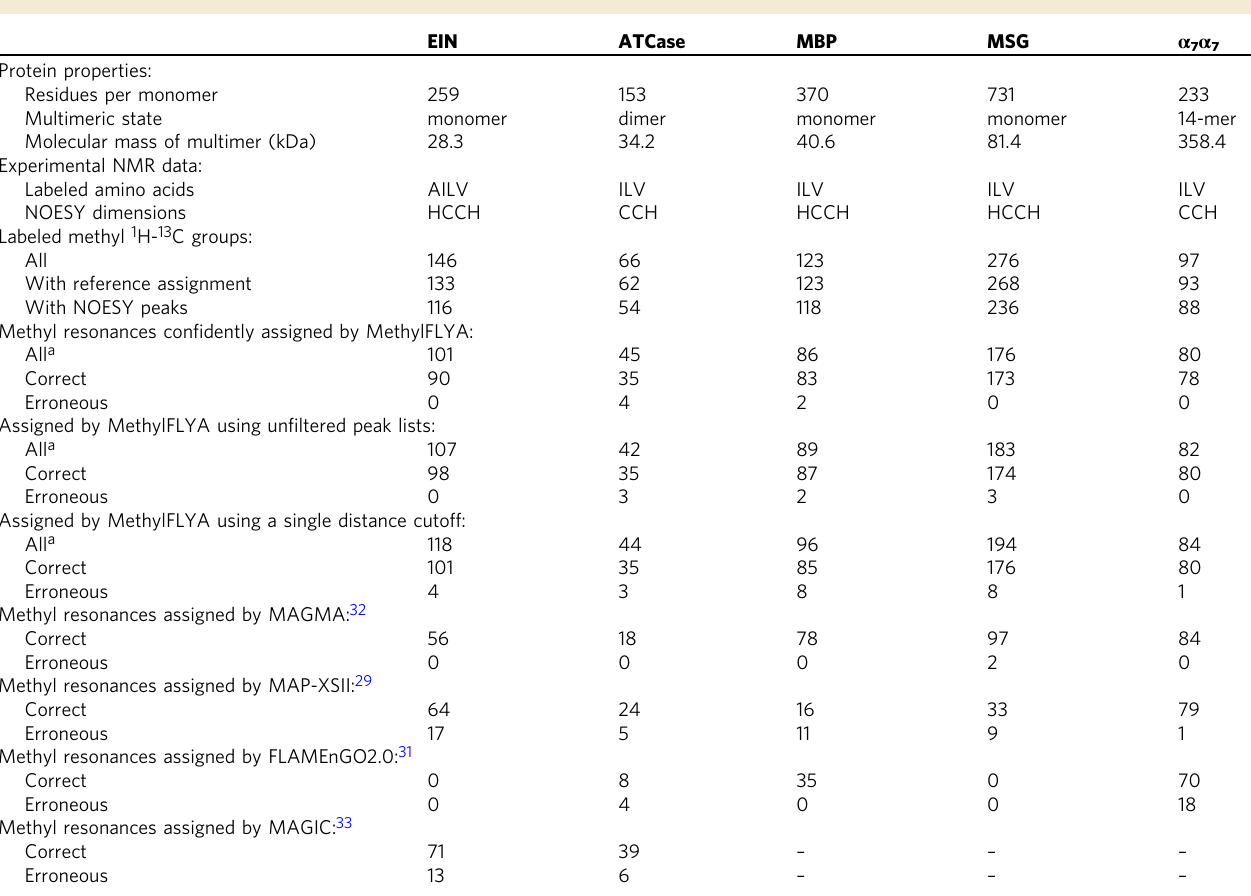
Table 1 Methyl resonance assignment statistics